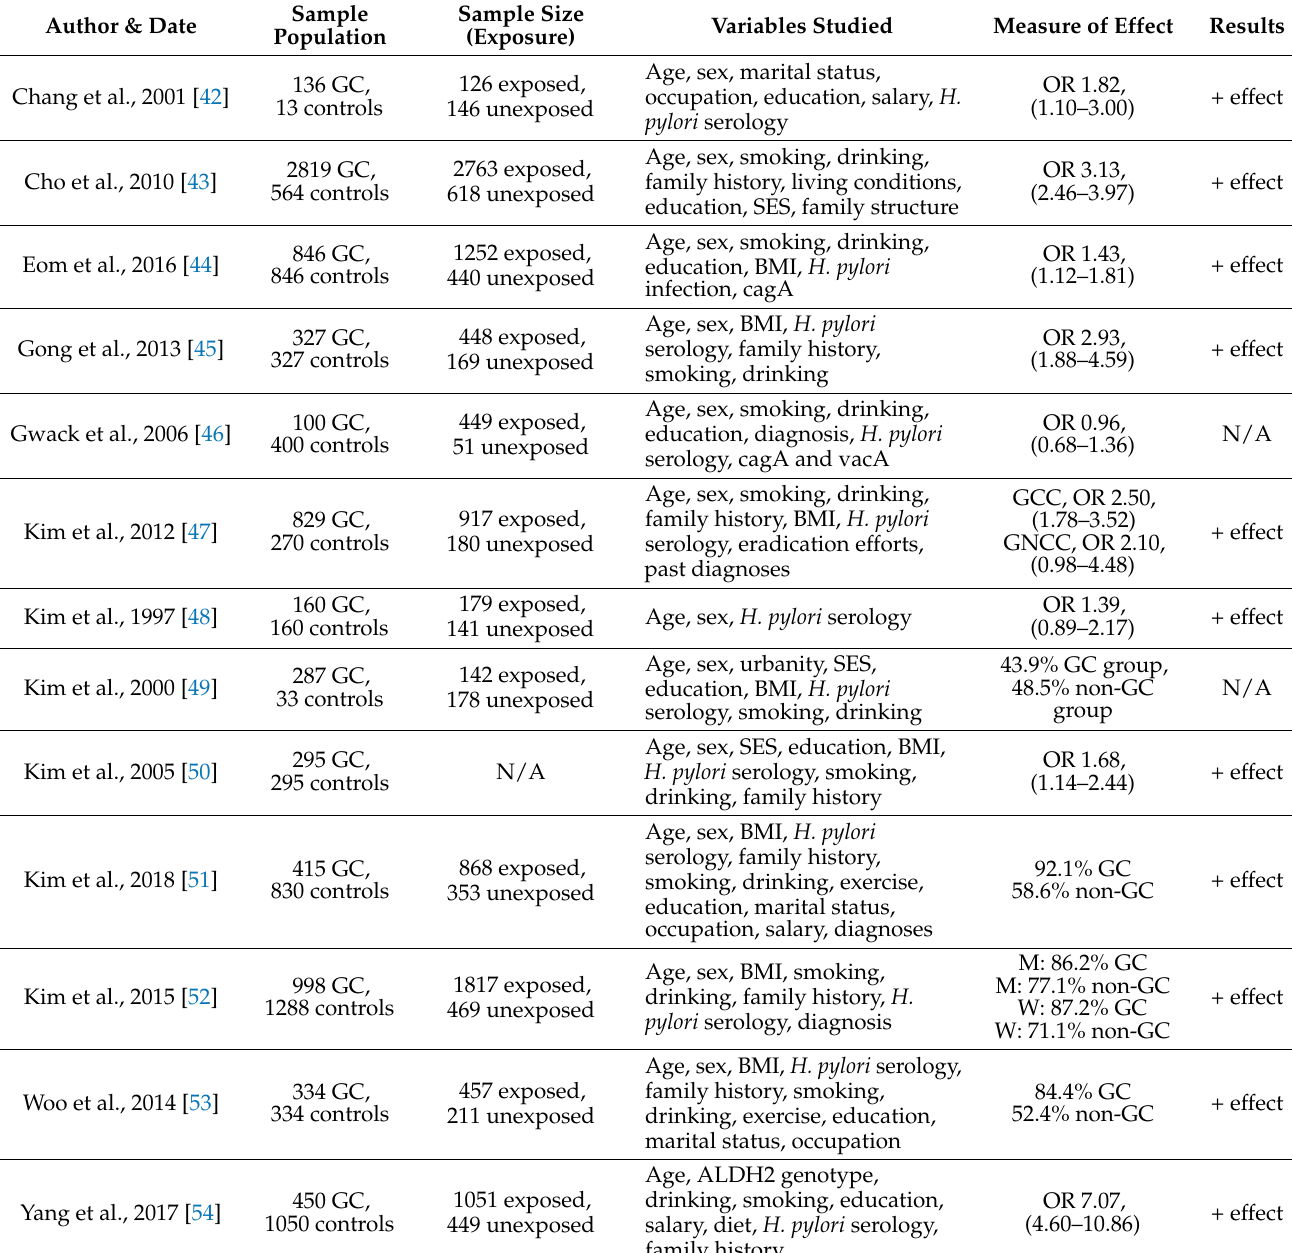
Table 1. Causal association of Helicobacter pylori and gastric cancer in South Korean